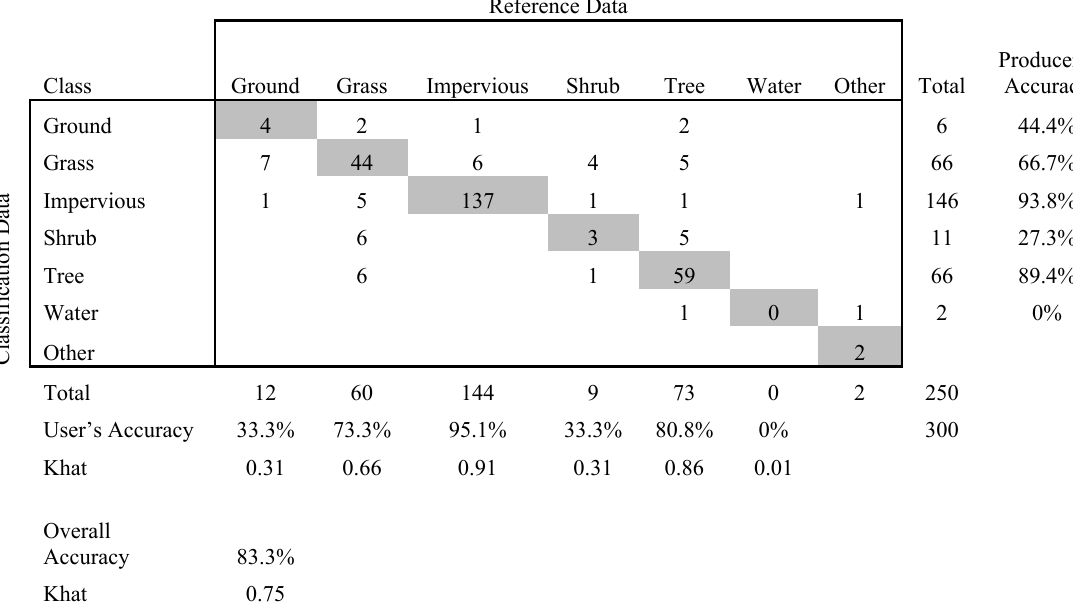
Table 6. Accuracy Assessment Confusion Matrix for Case Study